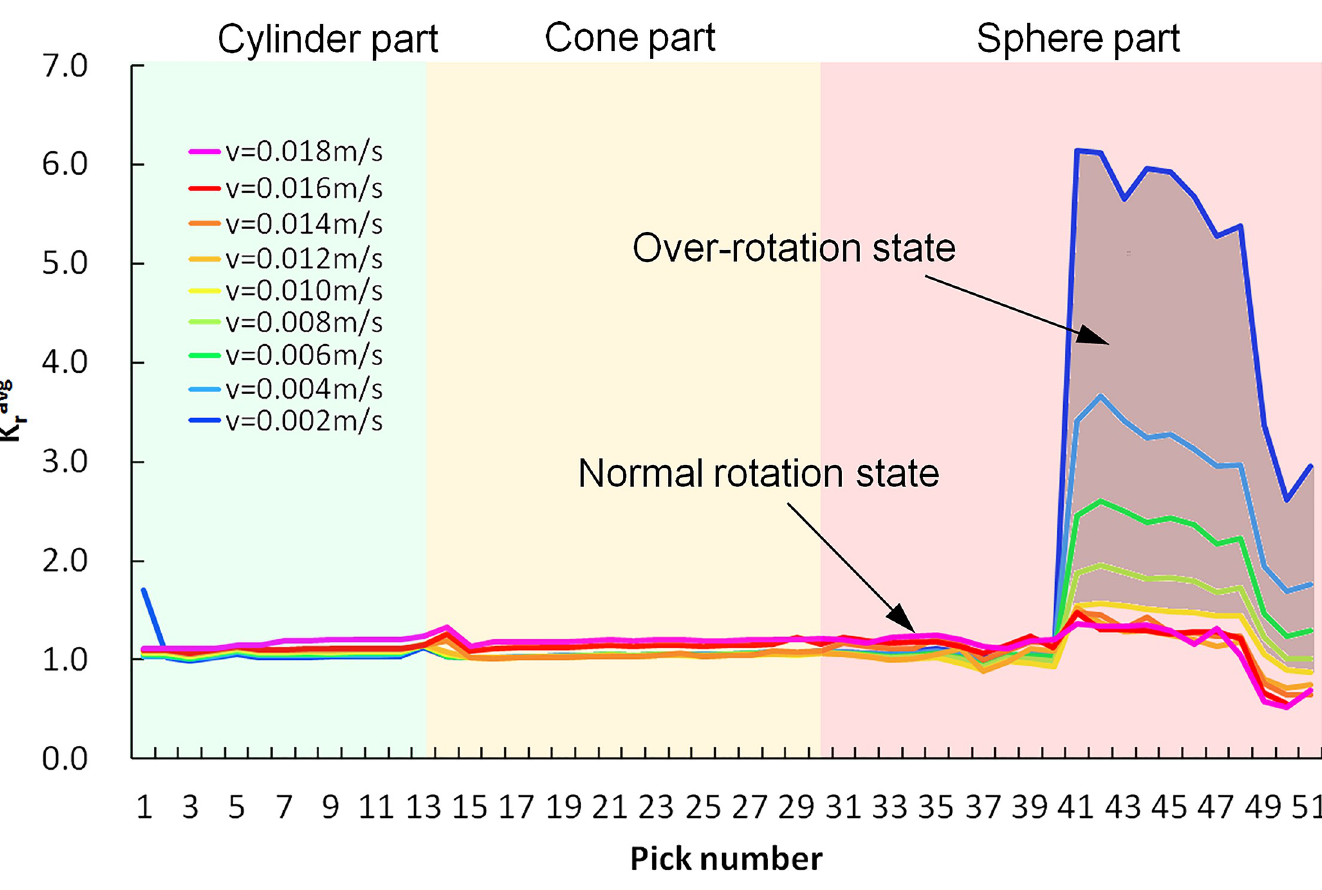
Fig 19. Rotation coefficient of each